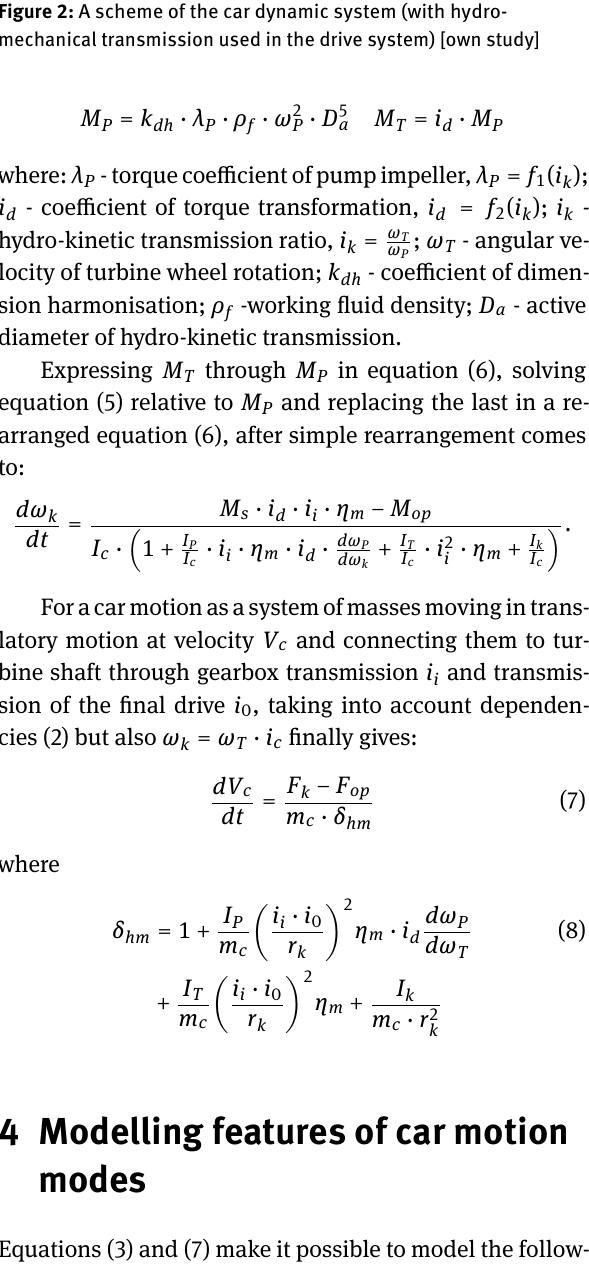
M P = k dh · λ P · ρ f · ω 2